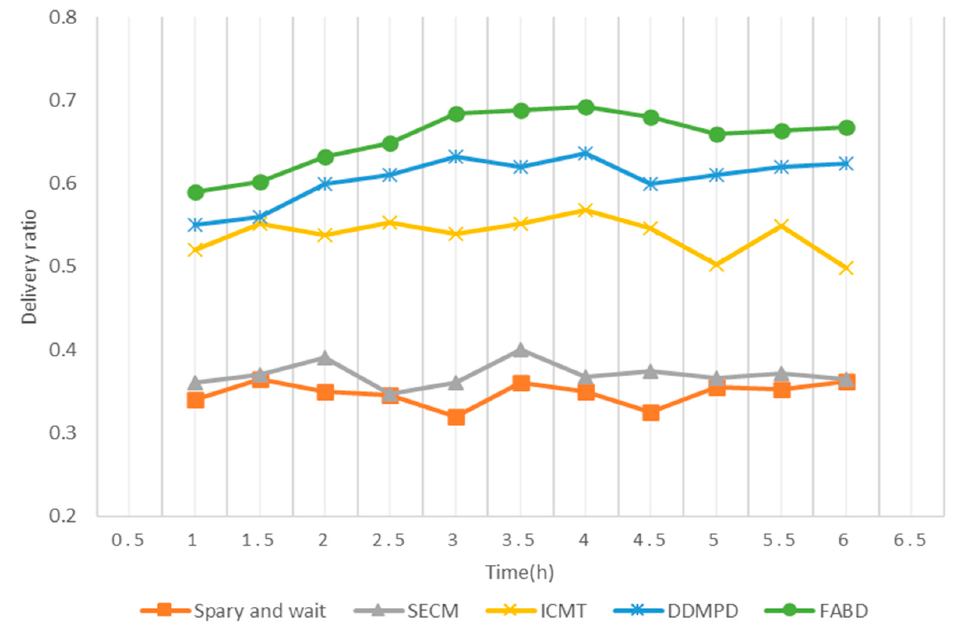
Figure 4. The relationship between delivery ratio and time.